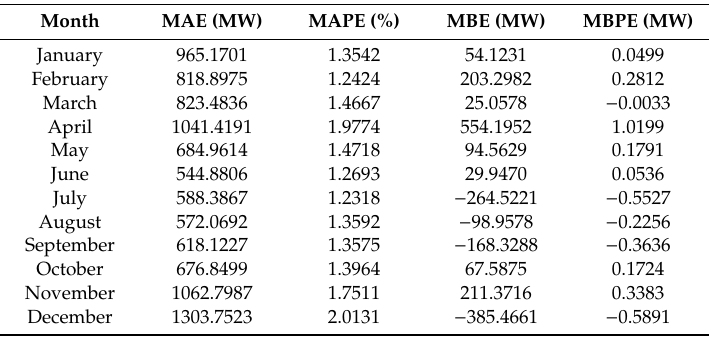
Table 3. Errors provided by the proposed deep learning structure.